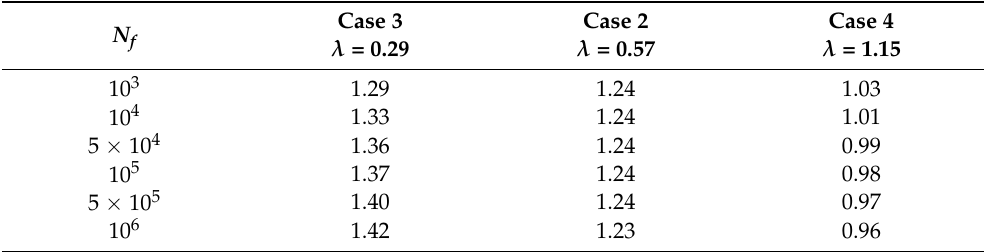
Table 9. Y normal variation with λ and N f